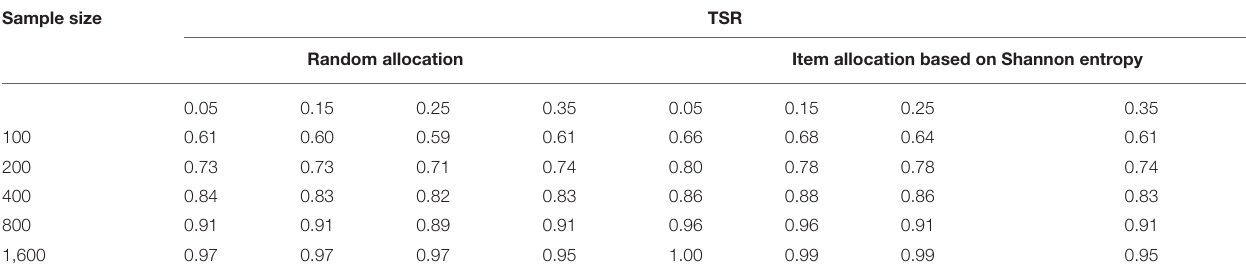
TABLE 2 | The TSR for the two allocation strategies under different initial values of the item parameters. Sample size